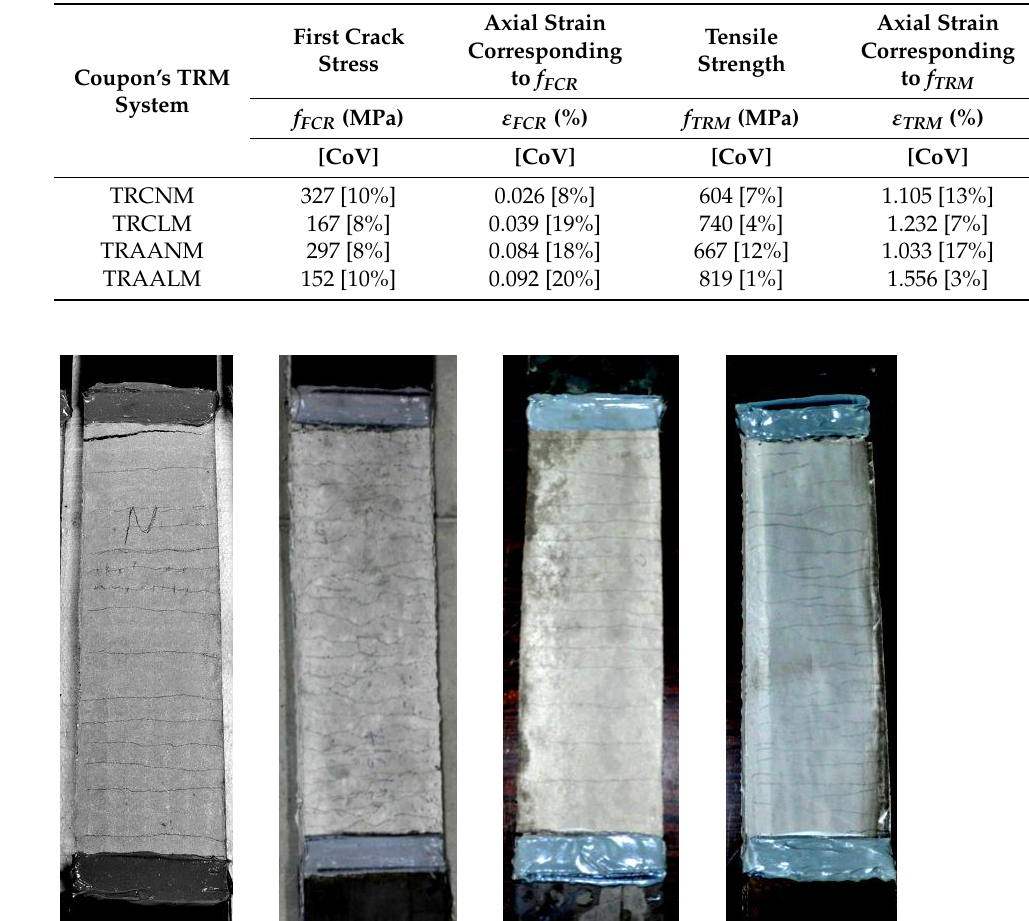
Figure 1. The axial tensile stress versus the axial tensile strain curves of: ( a ) textile-reinforced cementitious mortar and ( b ) textile-reinforced alkali-activated mortar coupons (stress is calculated by dividing with the load-aligned fibers’ cross section). Table 2. The mechanical characteristics of the textile reinforced mortar coupons.